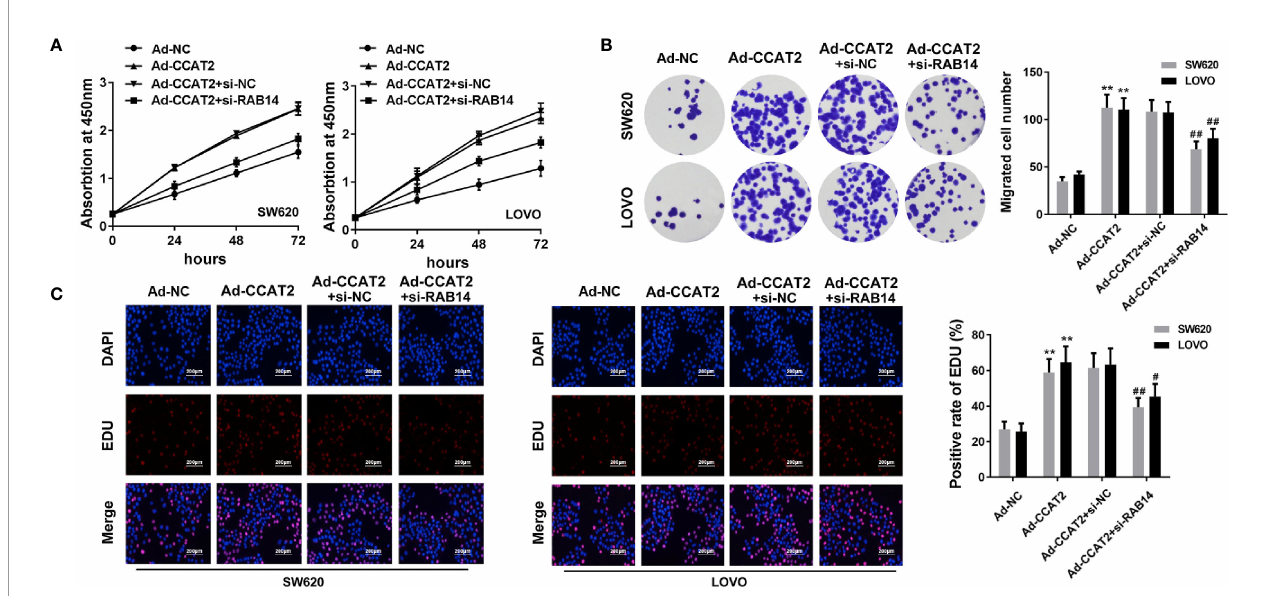
FIGURE 5 | RAB14 knockdown inhibited the proliferation-enhancing effect of CCAT2 on CRC cells in vitro . (A) Cell viability was assessed by CCK8 assay. (B) RAB14 downregulation reversed the effect of CCAT2 on the colony formation ability of SW620 and LOVO cells. (C) Cell proliferation was evaluated by EdU staining (×400). The data are represented as mean ± SD. Three independent biological repeats were used for each analysis. **P < 0.01 vs Ad-NC, # P < 0.05, ## P < 0.01 vs Ad-CCAT2+si-nc.